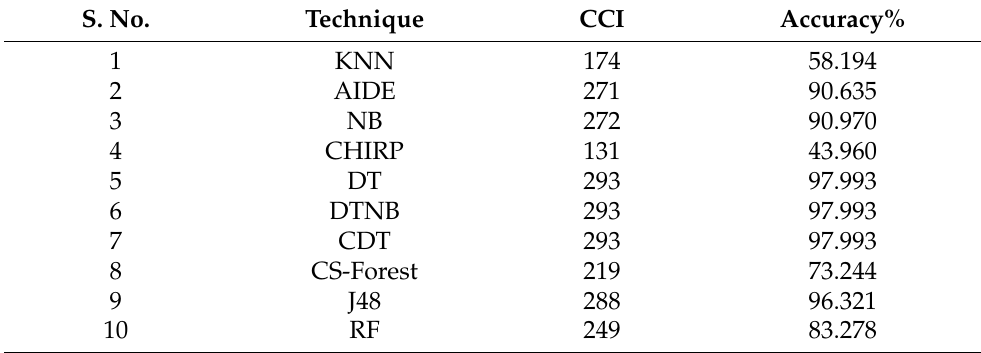
Table 28. CCI Details out of 299